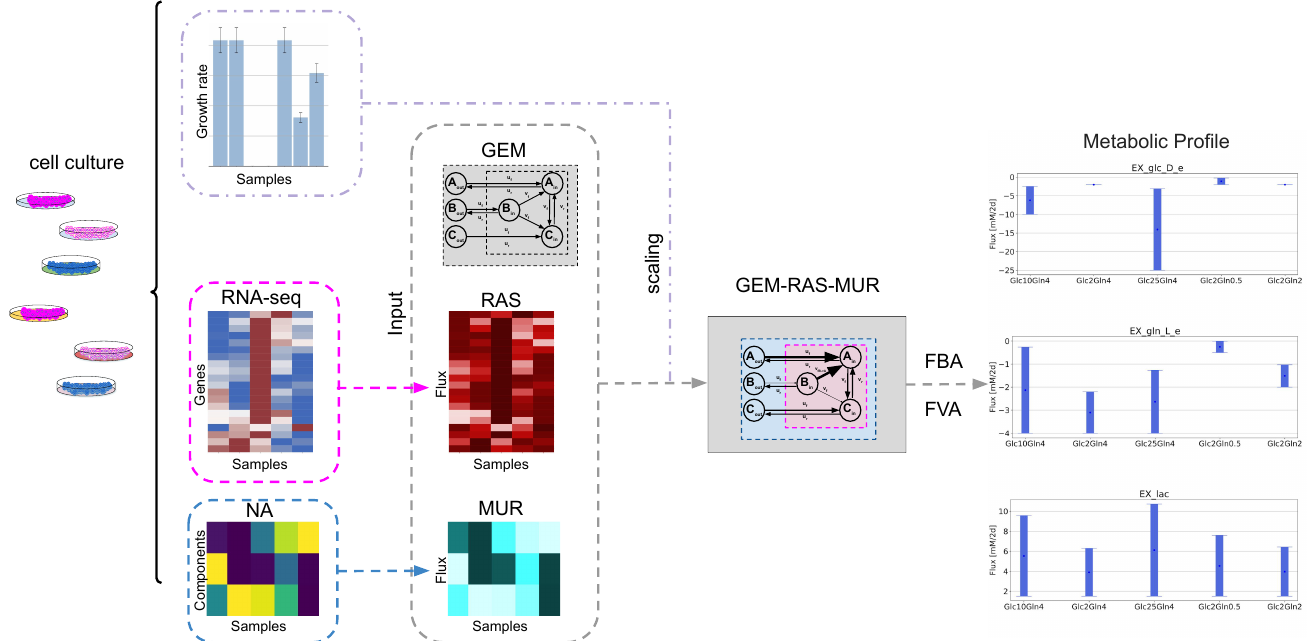
Figure 1. A visualization of the steps in genome-scale metabolic model (GEM)-based metabolic profiling. GEM-based integrated metabolic profiling requires three inputs: a genome-scale metabolic model (GEM), gene expression and nutrient availability data and one feature of the cells that distinguishes cells cultured in different conditions. In the first step of the proposed approach, similarly to Gene Expression and Nutrients Simultaneous Integration (GENSI) [23], the RNA-seq is converted into Reaction Activity Score (RAS) [26], which is defined for any reaction associated with a gene in the GEM as a function of the expression of the genes encoding for the subunits and/or the isoforms of the associated enzyme(s). Nutrient Availability (NA) is converted to Maximal Uptake Rate (MUR), which is defined for an exchange reaction j in GEM and describes the rate of the maximum possible uptake over the time for substances available for cells. NA is limited by a composition of media used in our experiments. Obtained GEM-RAS-MUR models are then used for metabolic profiling using optimization methods such as FBA [16,17] and FVA